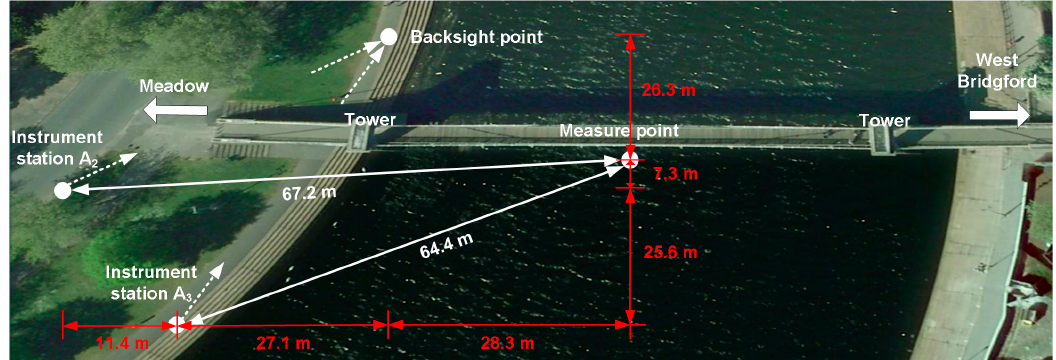
Figure 3. Instrument layout of full-scale experiments performed on the Wilford Suspension Bridge. The instrument stations for the composite instrument were set at the A2 and A3 sites in Cases 2 and 3, respectively. The backsight point was set at the upstream (north) side of the bridge; the measuring point was set at the mid-span of the studied footbridge.